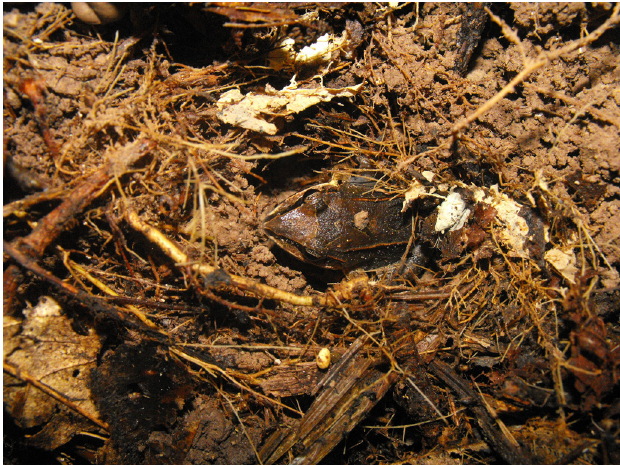
Figure 2. Leptodactylus didymus found vocalizing in a hole dug in primary forest floor next to the Juruparí River, Feijó Municipality, Acre, Brazil (Photo by N. M.